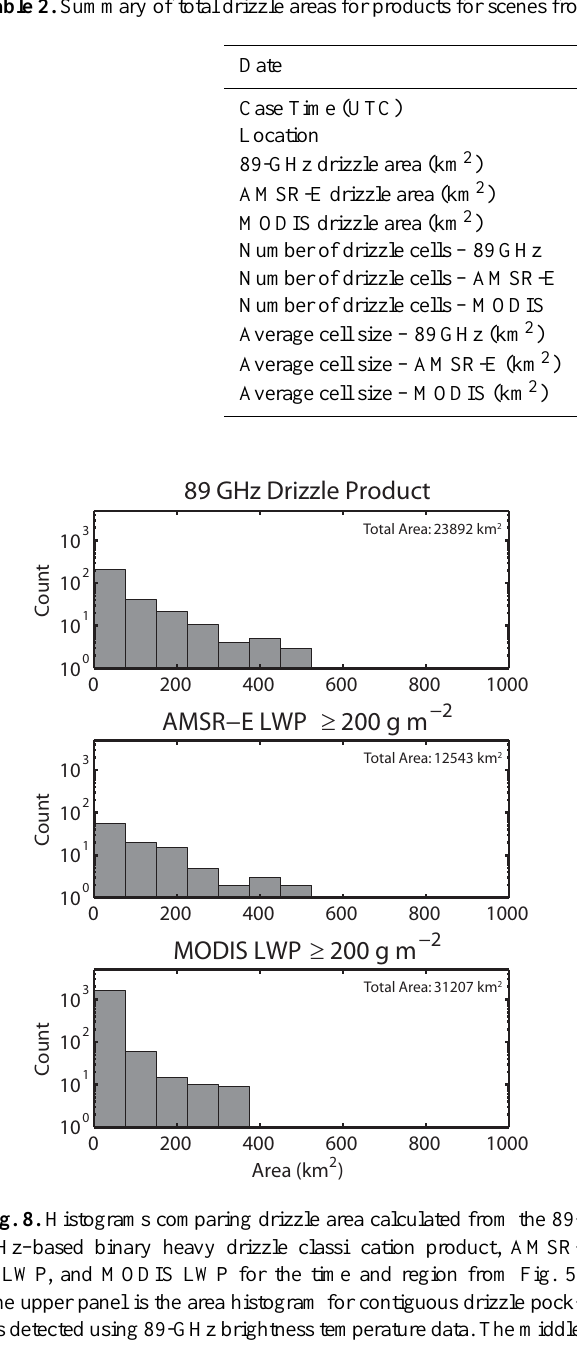
Table 2. Summary of total drizzle areas for products for scenes from Sect. 3.